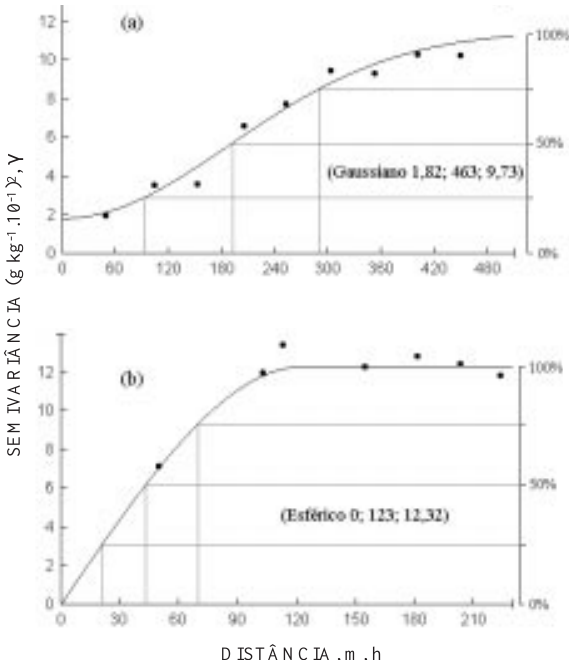
Figura 2. Semivariogramas para o teor de argila na camada superficial do solo nas direções (a) da linha de plantio e (b) da toposseqüência. (Entre parênteses; modelo; efeito pepita; alcance e